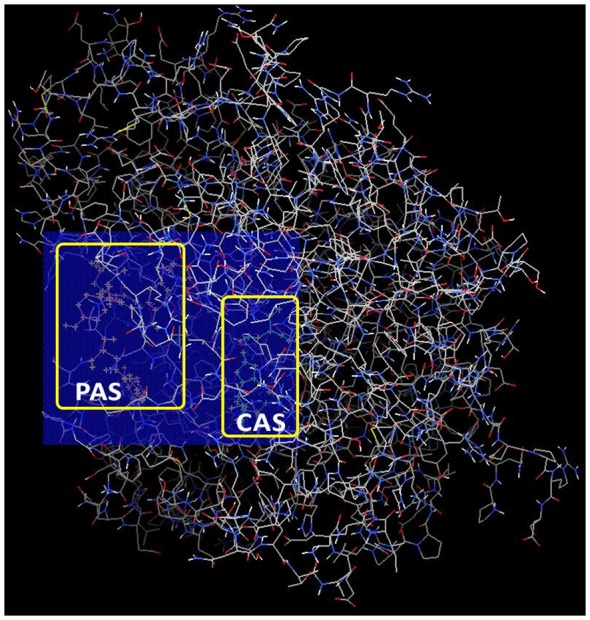
Relative position of AutoGrid box in acetylcholinesterase (AChE) encompassing both catalytic action site (CAS) and peripheral anionic site (PAS) docking sites.